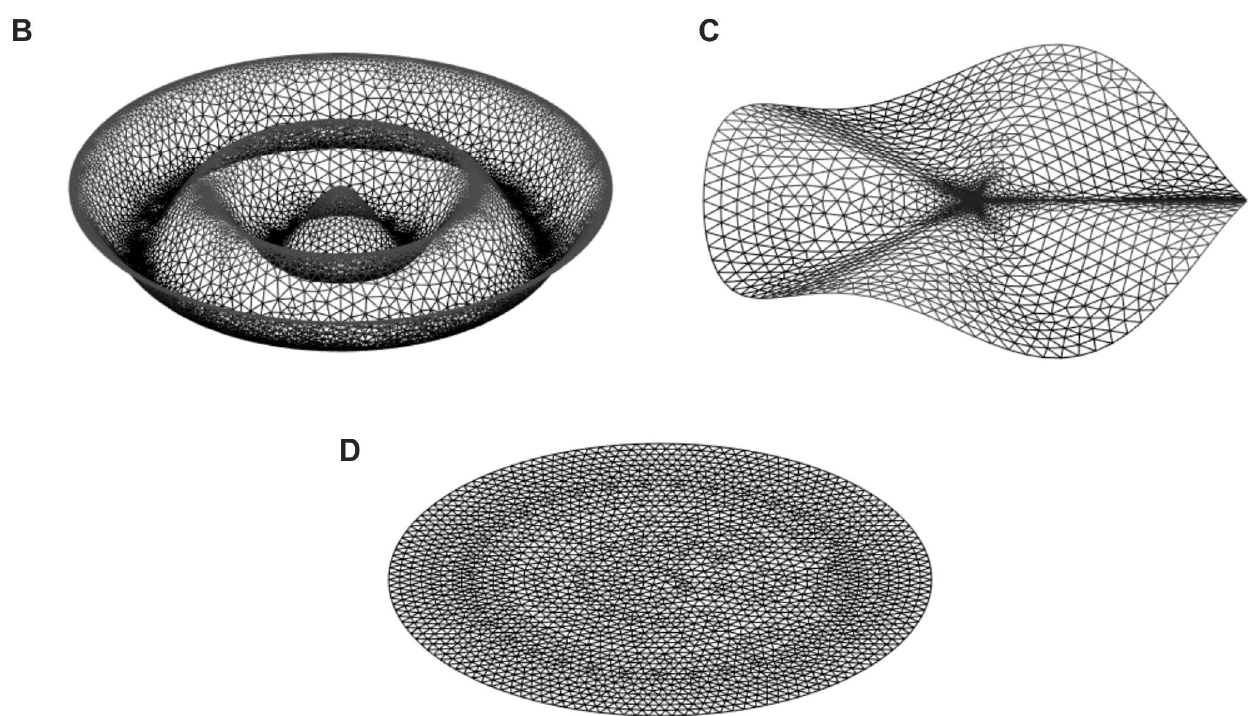
Figure 1. Different finite element geometries and meshes. ( A ) Schematic representation of the model for voltage clamp (left) and current clamp protocols (right). The extracellular potential (V e ) at the rim of the disc was set to zero (red). The schematic was modified from Hichri et al. [14]. ( B ) Intercalated disc mesh consisting of concentric folds parametrized by amplitude A and number of folds N. In this example, A = 1/8 R ID and N = 4. ( C ) Intercalated disc mesh consisting of radial folds parametrized by A and N. In this example, A = 1/8 R ID and N = 4. ( D ) Reference mesh of a flat intercalated disc.